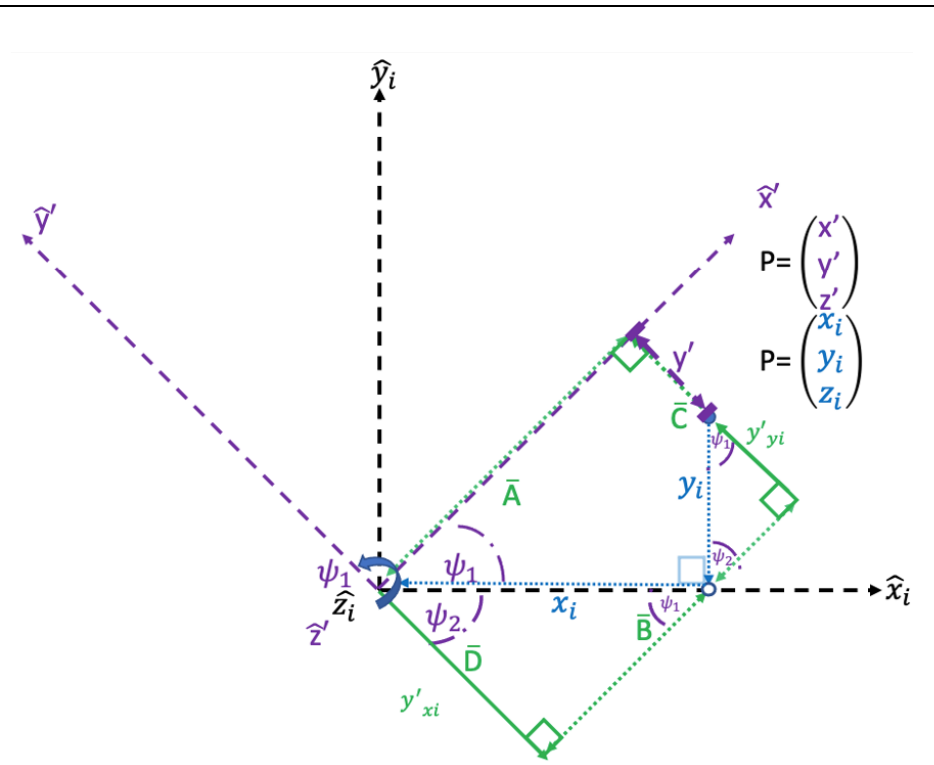
Figure 14. 3-rotation about the 𝑧 𝑖 ̂ and 𝑧′̂ axes highlighting 𝑦′ 𝑥𝑖 and 𝑦′ 𝑦𝑖 as part of rectangle 𝐴𝐵𝐶𝐷̅̅̅̅̅̅̅̅ .